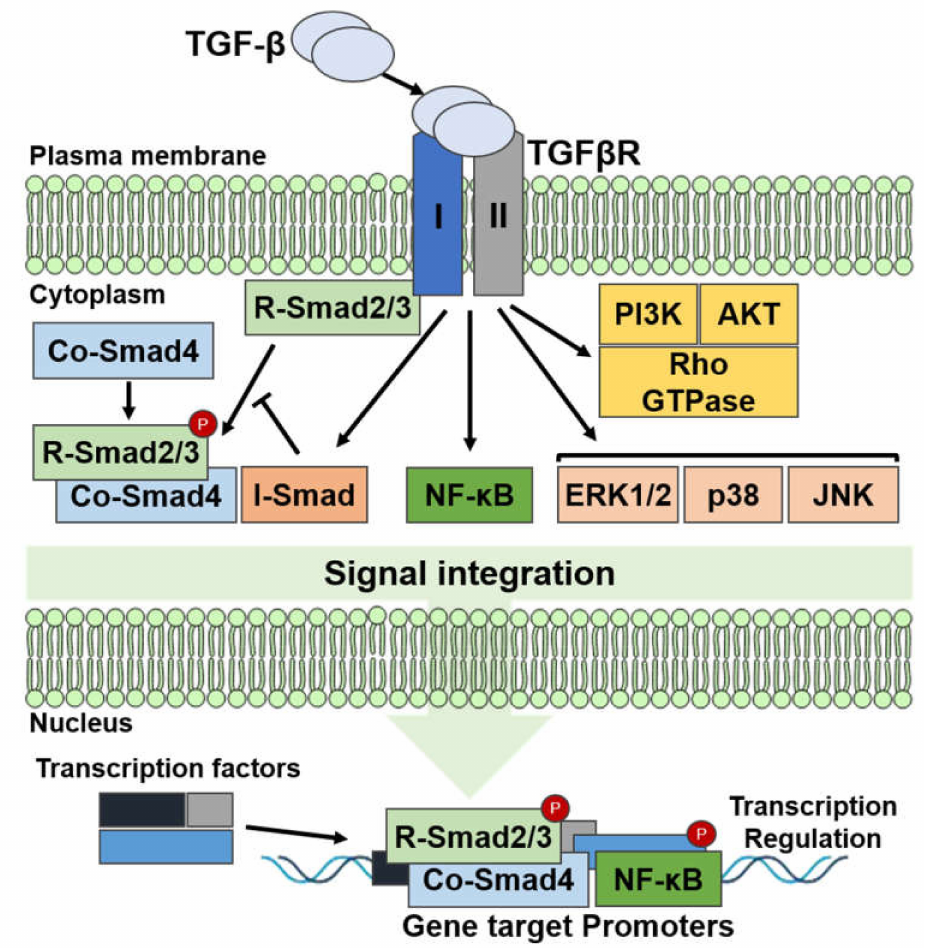
Figure 2. TGF- β signaling